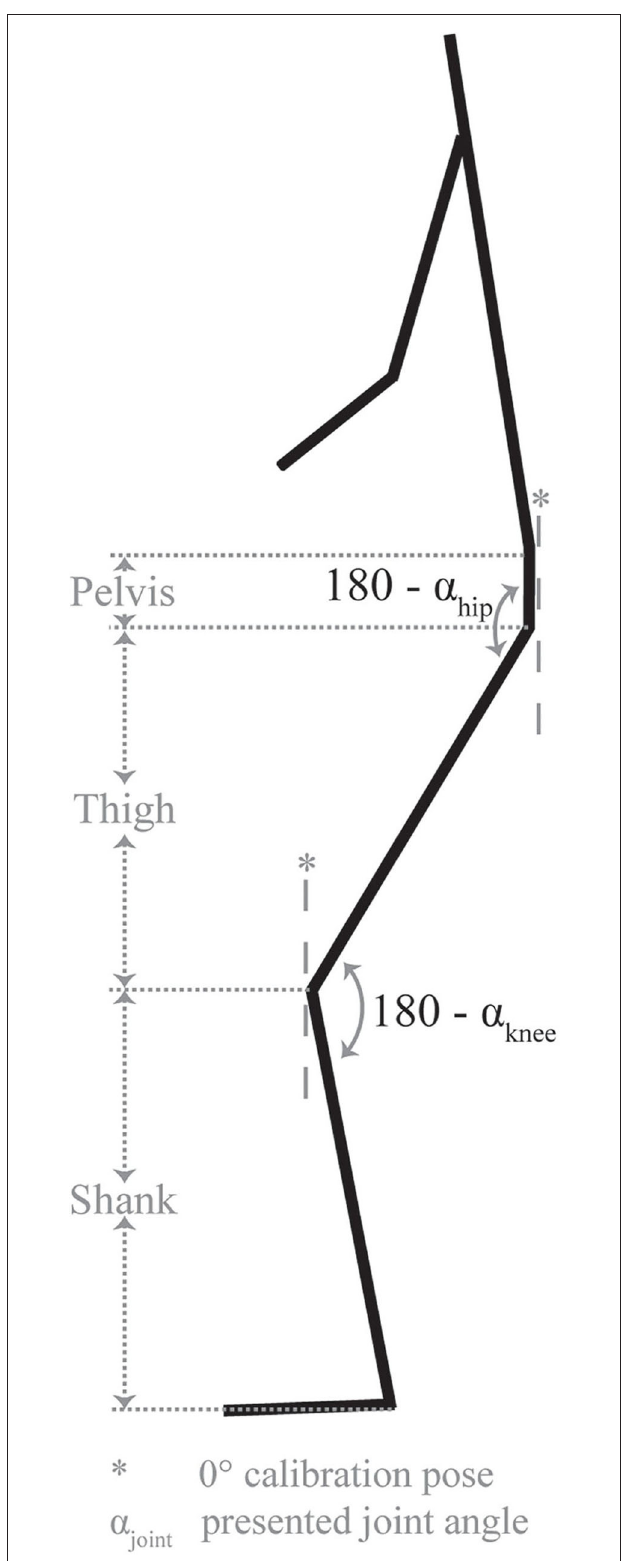
FIGURE 2 | Joint angle